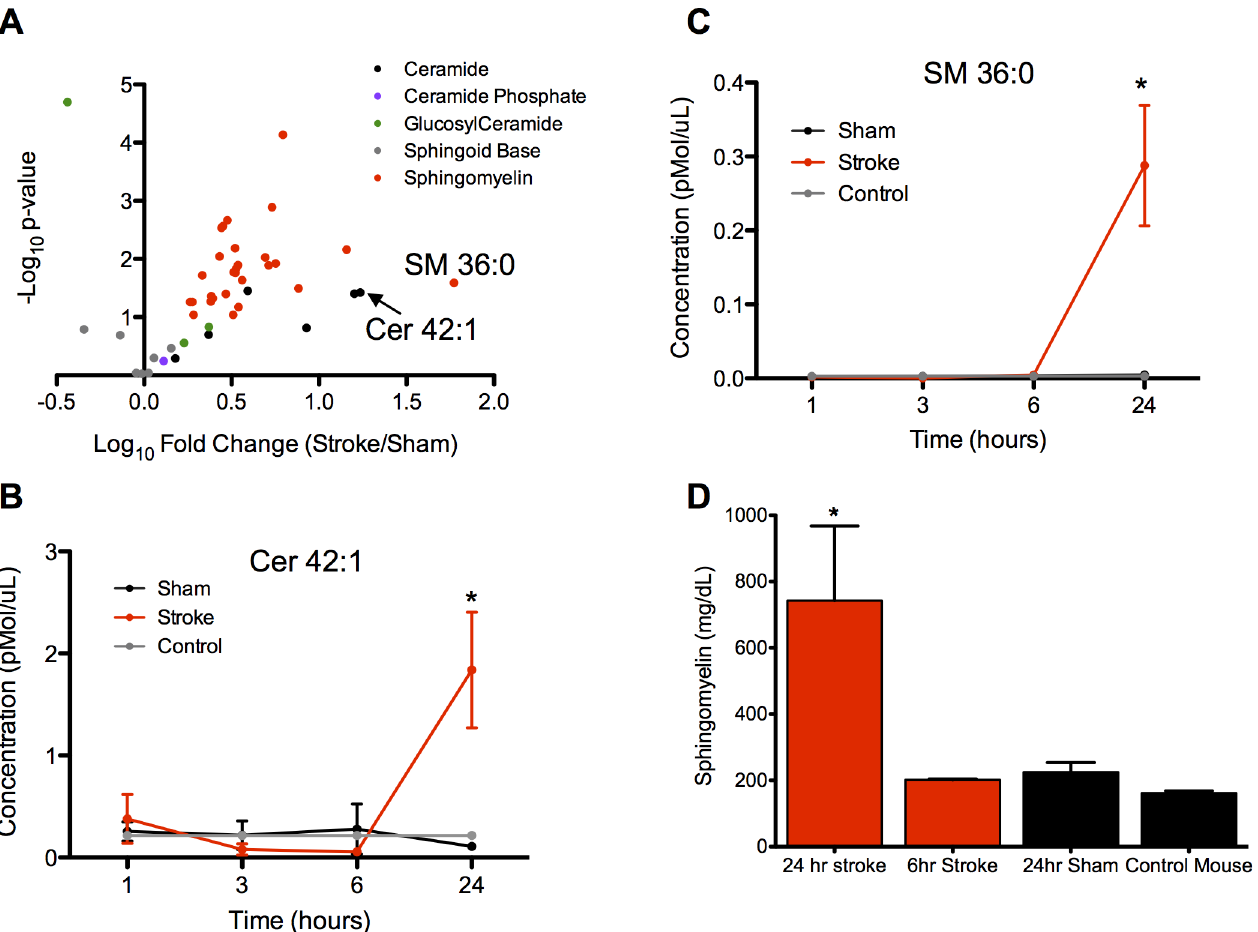
Fig 2. Sphingolipid profiling in middle cerebral artery occlusion in mice. (a) Volcano plot of the negative log 10 of the p-value (Student ’ s t-test, two-tailed) versus the log 10 of the normalized fold change in plasma concentration of stroke over sham animals at the 24 hour time point. Selected top performing sphingolipids are indicated by labels. n = 3 per sample. (b and c) Time course of the two sphingolipids with the greatest fold change. Red line indicates stroke animal, black line indicates sham animal, and grey line indicates control animal without any surgical procedure but with identical blood collection process. Data are shown as mean ± SEM. * indicates p < 0.05, Student ’ s t-test, two-tailed. n = 3 per sample. (d) Total sphingomyelin concentration in plasma as measured by biochemical assay. * indicates p < 0.05, one-way ANOVA with Dunnett ’ s multiple comparisons test.